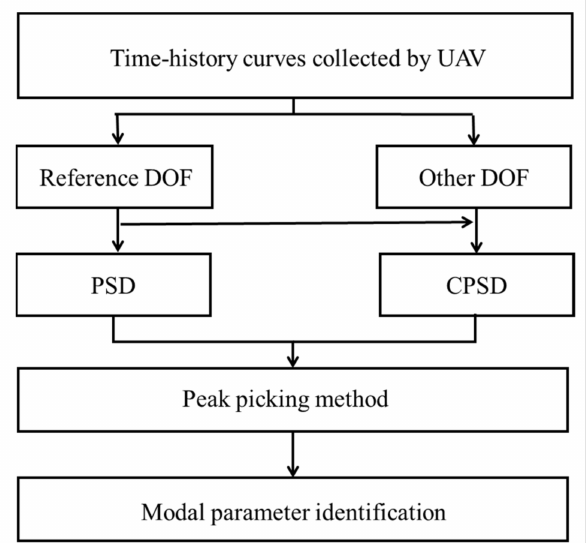
Figure 3. Flowsheet of operational modal